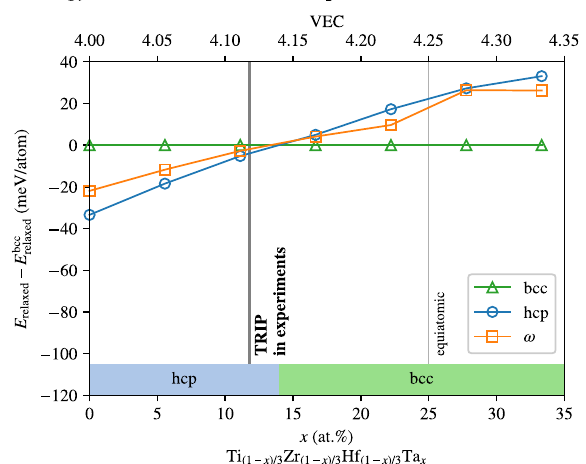
Fig. 6 Phase stabilities with respect to the bcc phase for the pseudobinary section Ti (1 − x )/3 Zr (1 − x )/3 Hf (1 − x )/3 Ta x . a Atoms fi xed to the ideal lattice sites. b Atoms allowed to relax. The energies shown for ω correspond to the defect-free ω structure. The bcc – hcp TRIP composition con fi rmed by experiments ( ≈ 12 at.% 6 ) is shown by the thick gray vertical line.